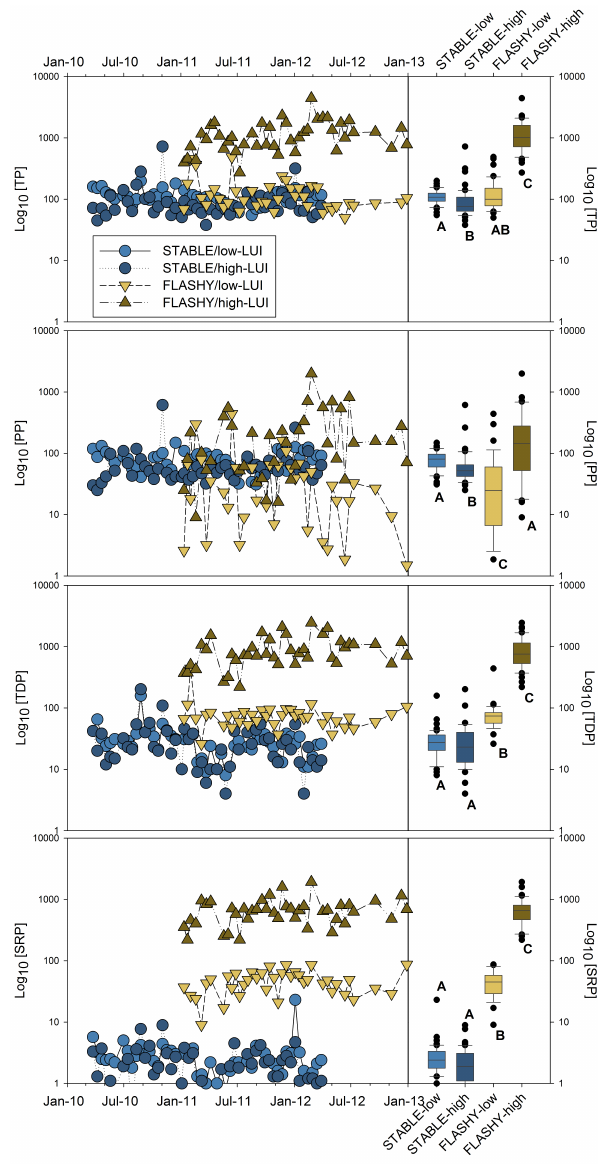
Figure 3. From top to bottom panels: temporal variation of to- tal (TP), particulate (PP), total dissolved (TDP), and soluble re- active phosphorus (SRP) concentrations from grab samples for all the monitored catchments. log 10 scale was selected on the vertical axe to improve vizualisation. The phosphorus concentration is al- ways expressed as µgPL − 1 . Right panels: boxplots are based on the same data. Letters A, B, and C are used to display statistical groups according post hoc paired comparison analysis. The bound- ary of the box closest to zero indicates the 25th percentile, a line within the box marks the median, and the boundary of the box far- thest from zero indicates the 75th percentile. Whiskers above and below the box indicate the 90th and 10th percentiles. Black dots dis- play outliers. STABLE: low-flashiness Danish streams; FLASHY: Uruguayan flashy streams; low- and high-LUI: low and high land use